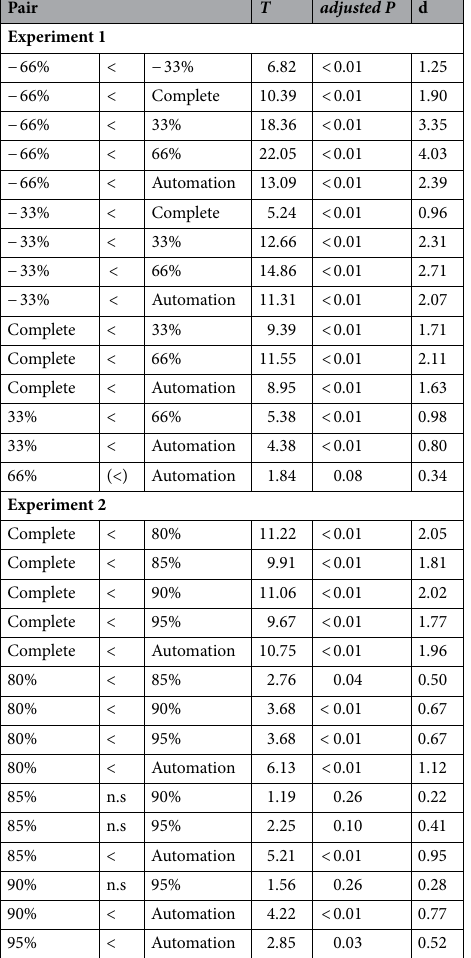
Table 2. Multiple comparison using Shaffer’s modified sequentially rejective Bonferroni procedure: Performance